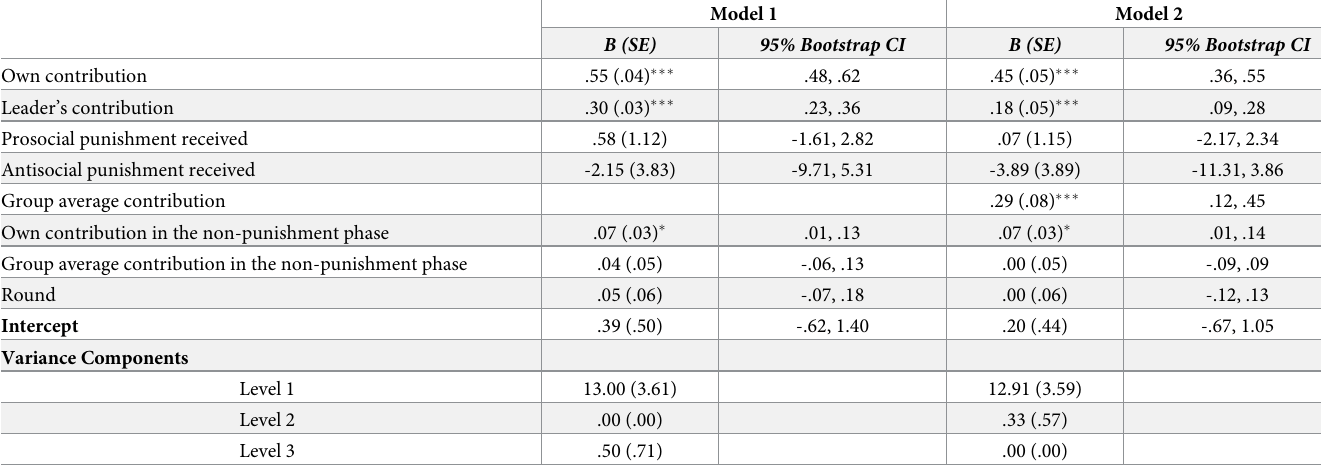
Table 1. Leader contribution decision in the previous round predicts non-leader cooperation in the next round within the